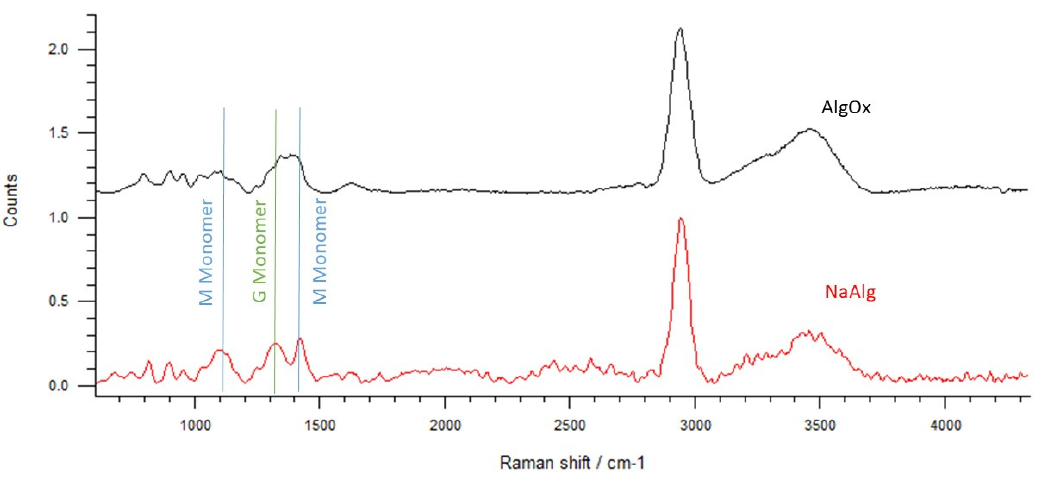
Figure 2. Raman spectra of NaAlg (red line) and AlgOX (black line).